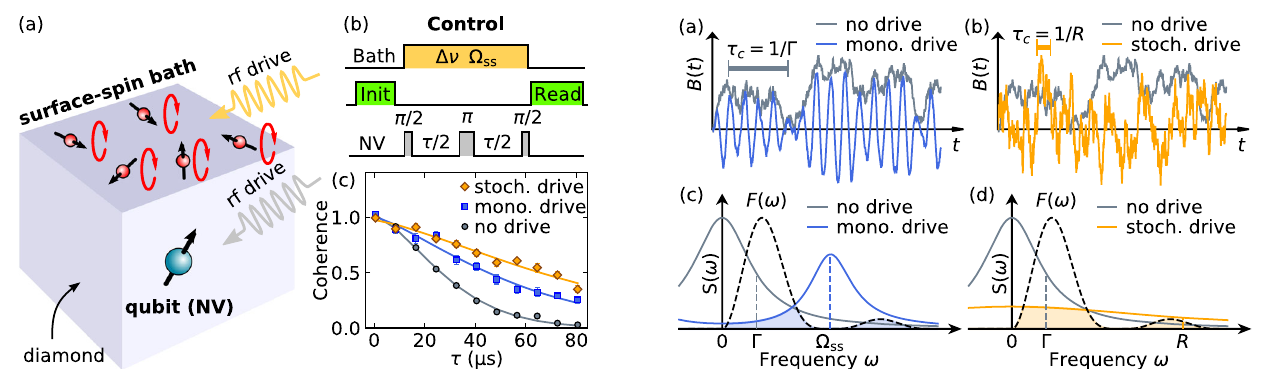
Fig. 1 Coherence extension by driving the spin bath. a A shallow NV center (qubit) is dephased by the magnetic noise originating from a bath of surface spins. b Hahn-echo sequence used to measure coherence during bath driving with linewidth Δ ν and Rabi frequency Ω ss . c Coherence decay without driving (gray), with monochromatic driving (blue) and polychromatic/stochastic driving (orange), described in the text. Solid lines are fi ts to exp (cid:2)ð τ = T 2 Þ n ½ (cid:3) . Error bars correspond to ± one standard error of the mean.